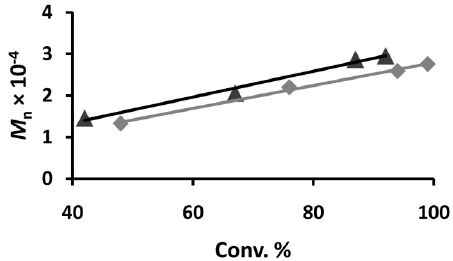
Figure 3. M n vs. monomer conversion in the ROP of ε -CL (gray, runs 3 and 7–9 in Table 1) and rac -LA (dark, runs 2 and 6–8 in Table 2) initiated by Al2 /BnOH.